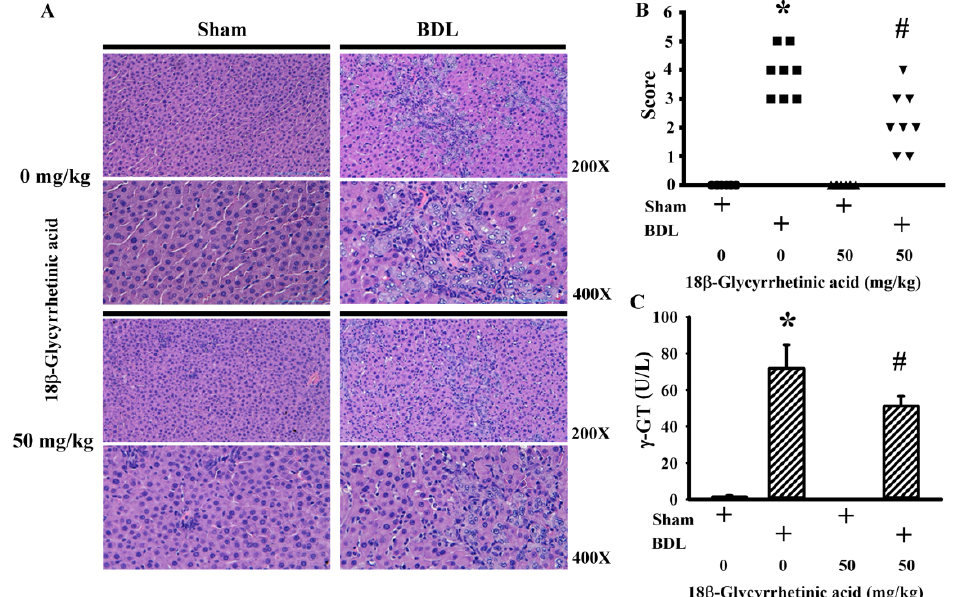
Figure 3. 18 β -Glycyrrhetinic acid alleviated BDL-induced liver histopathological changes in the treatment study. The paraffin-embedded liver tissues were subjected to histological examination. Representative photomicrographs of H&E staining are shown. Original magnification is 200× and 400× ( A ). The severity of bile duct hyperplasia is scored ( B ). Serum levels of γ -GT activity were measured ( C ). * p < 0.05 vs. the sham vehicle group and # p < 0.05 vs. the BDL vehicle group, n = 8.